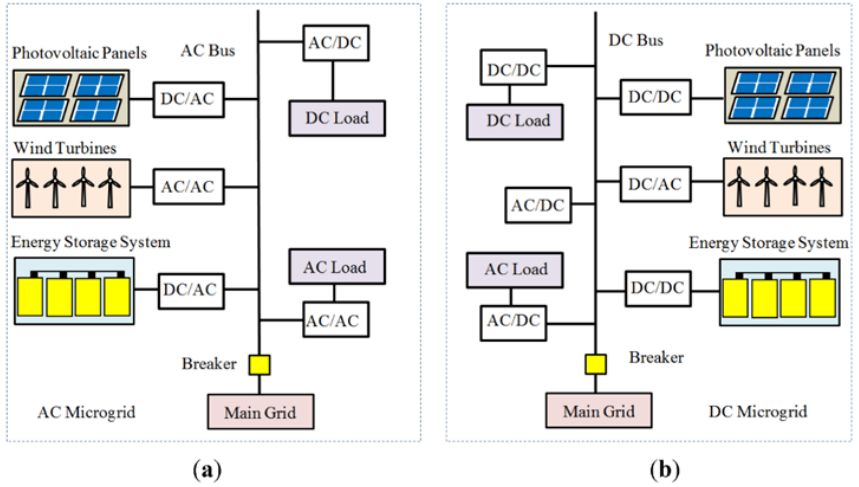
Figure 4. Architecture comparison: ( a ) AC microgrid; and ( b ) DC